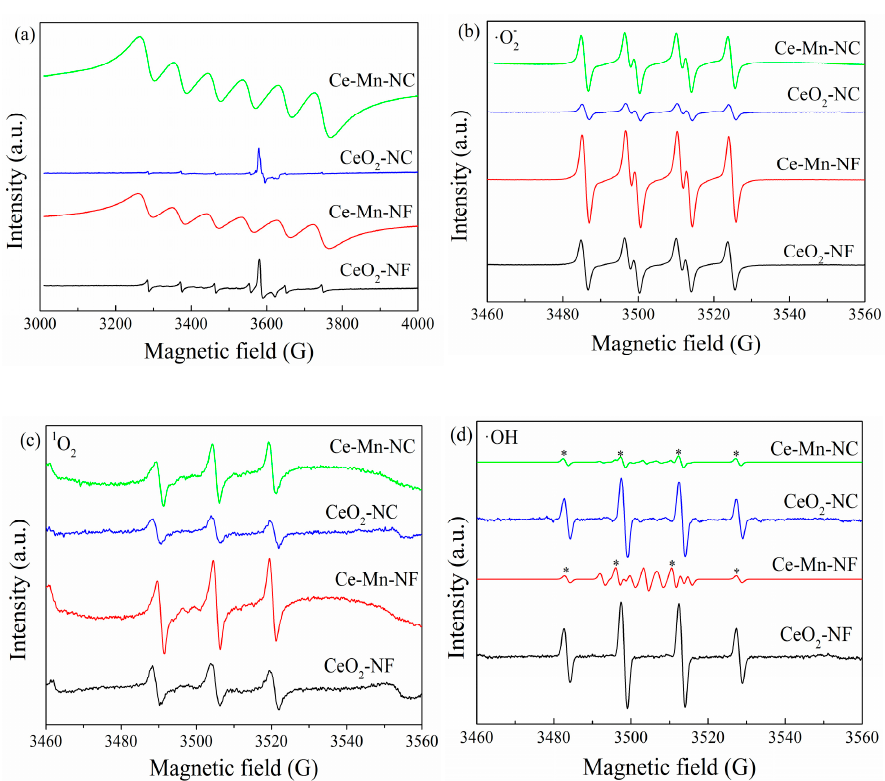
Figure 6. Electron paramagnetic resonance signals of all the samples ( a ), superoxide radical ( b ), singlet oxygen ( c ) and hydroxyl radical ( d ).